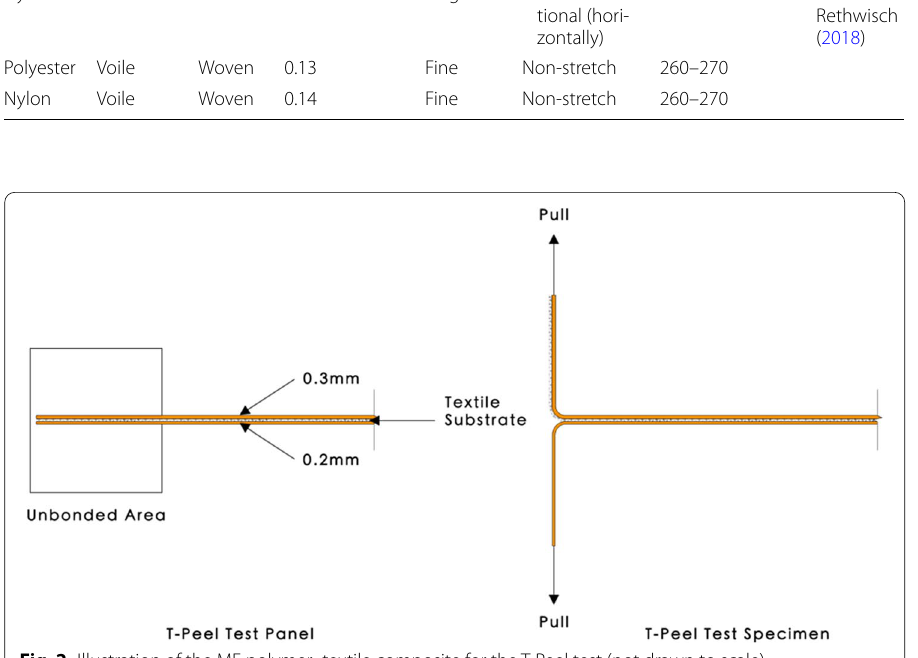
Fig. 2 Illustration of the ME polymer–textile composite for the T-Peel test (not drawn to